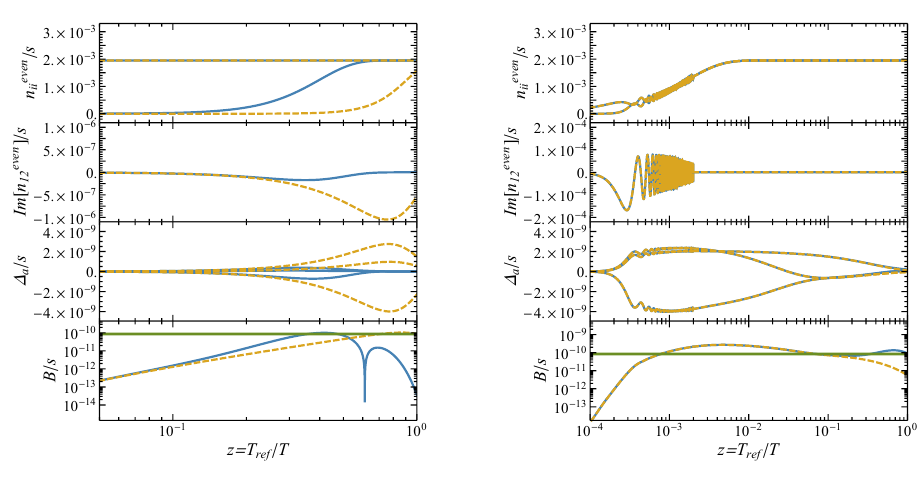
Figure 2 . The evolution of the number densities with (blue, full), and without (yellow, dashed) the lepton number violating processes. In the left panel we present a point in parameter space where the lepton number violating processes suppress the (cid:12)nal BAU. Without the LNV processes, this point is allowed because the equilibration of the RHN number can be postponed arbitrarily by adjusting the mass splitting. This is, however, not possible in the presence of the lepton number violating processes, as they enhance the equilibration rate of the weakly coupled RHN (cid:13)avour. In the right panel we present an example where the BAU is enhanced through the presence of the lepton number violating processes. Note that while the evolution of the active and sterile charges with and without lepton number violation is almost identical at early times, it changes dramatically at late times where the lepton number violating term becomes large. If the LNV processes are neglected, the washout of the RHN charges suppresses the total lepton number asymmetry. In the presence of LNV processes this suppression is not as e(cid:11)ective, leading to a larger (cid:12)nal BAU. corresponds to a logarithmic prior in U 2 (cid:24) e 2Im ! . The upper limit Im ! < 7 does not limit the scan; in practice we (cid:12)nd that the observed BAU cannot be produced for larger values of Im ! due to a stronger